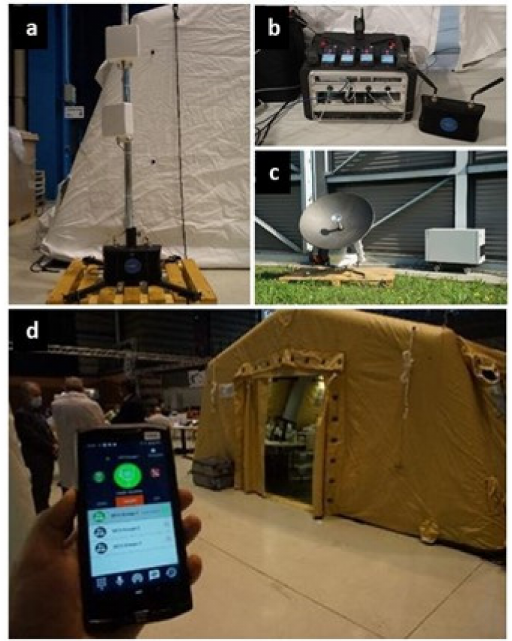
Figure 13. B-LiFE deployment in Turin, Italy, during the COVID-19 crisis: ETELM equipment (TETRA and LTE base stations and subscriber terminal) used for the terrestrial